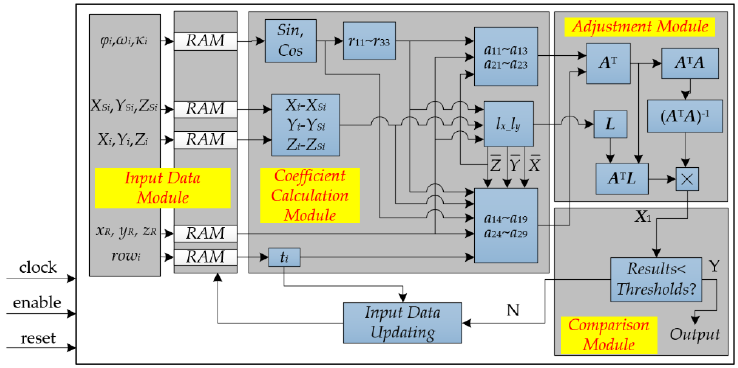
Figure 5. The proposed implementation of on-board geometric calibration.